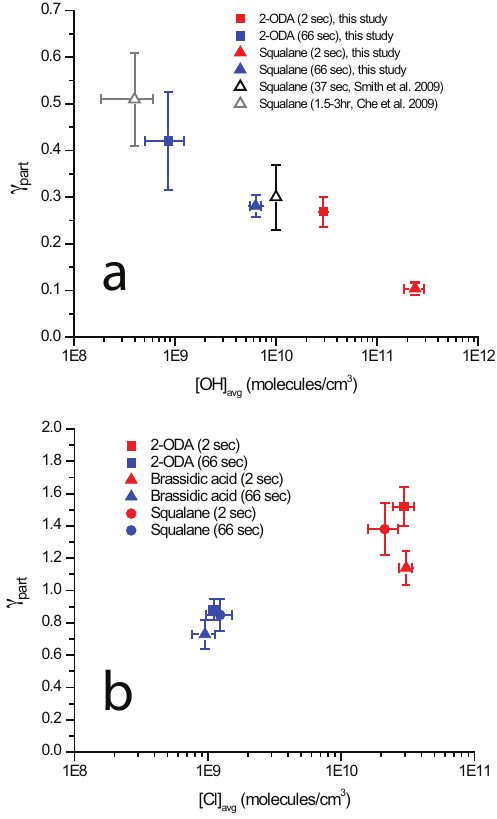
Fig. 3. (a) Effective reactive uptake coefficient, γ part , of OH on 2- ODA particles and Sq particles in the large and small flow tubes as a function of OH concentration. The data of Che et al. (2009) and Smith et al. (2009) are shown for comparison. (b) Effective reactive uptake coefficient, γ part , of Cl on 2-ODA, Sq, and BA particles in the large and small flow tubes as a function of Cl